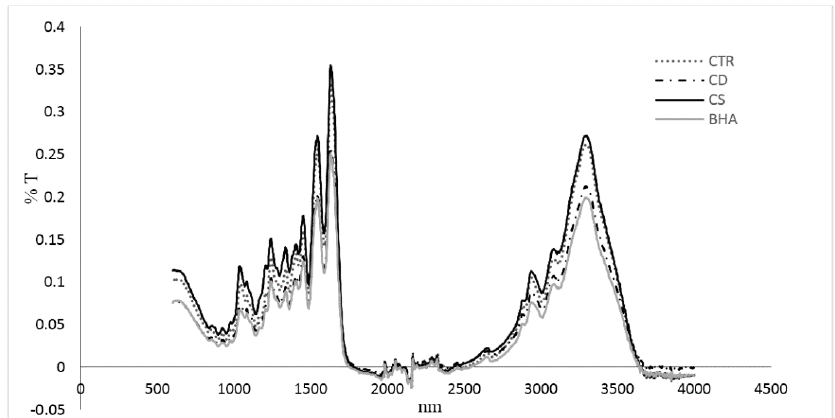
Figure 2. Infrared spectra of gelatine-based films treated with different samples: CTR (control), BHA, CS3 and CD3 .